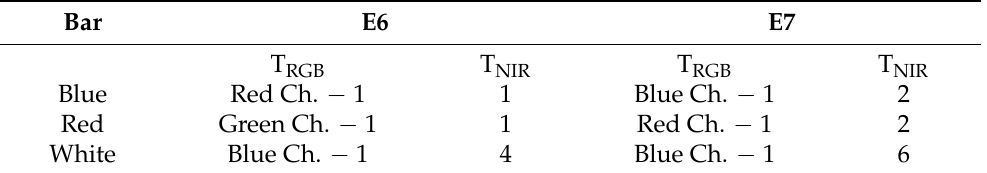
Table 6. Optimal combinations of gray-scale conversion modality (red, green, and blue channel, ch.) and number of segmentation classes (T RGB and T NIR for RGB and NIR, respectively) for each bar (blue, red, and white) and experimental test (E6 and E7). Images are treated with the narrow crop. Bar E6 E7 T RGB T NIR T RGB T NIR Blue Red Ch. − 1 1 Blue Ch. − 1 2 Red Green Ch. − 1 1 Red Ch. − 1 2 White Blue Ch. − 1 4 Blue Ch. −